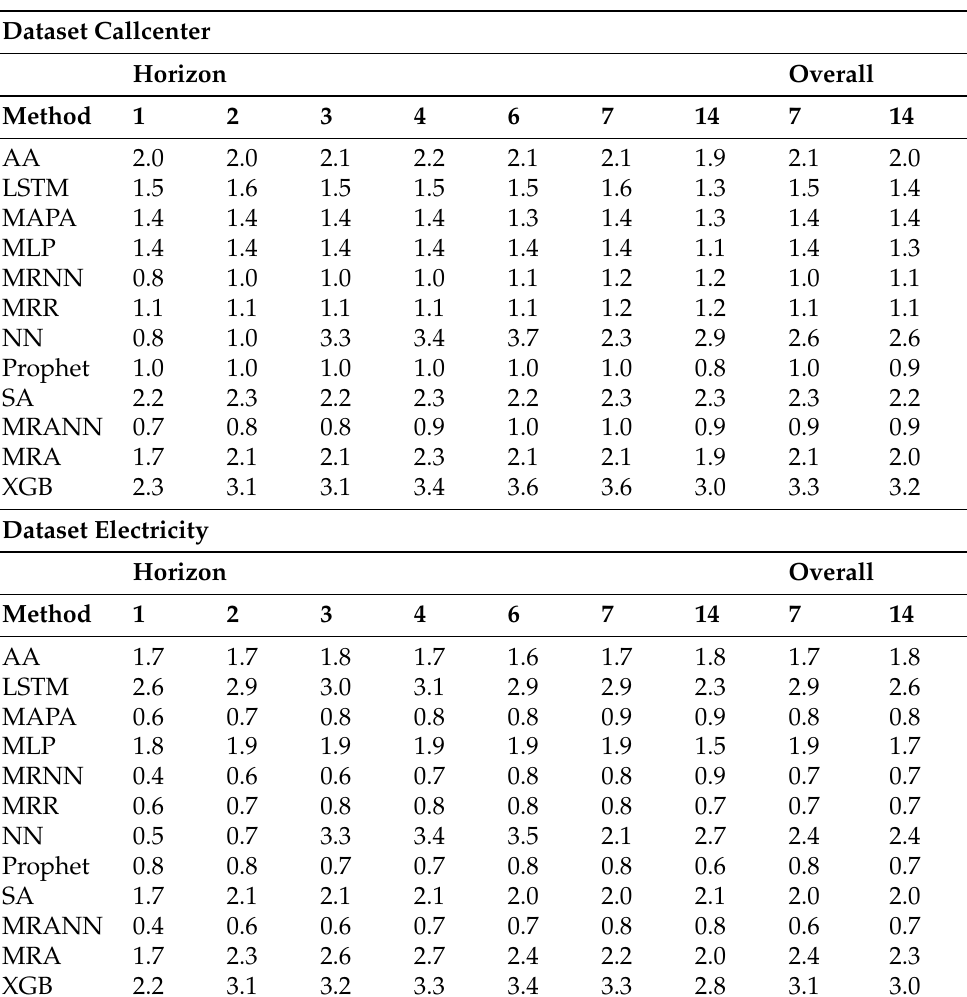
Table 1. Average MASE of multi-step forecasts from Prophet, MAPA, the two multiresolution forecasting methods MRR using regression, and MRNN using a neural network, seasonal adapted ARIMA (SA), automatized ARIMA (AA), multilayer perceptron (MLP), long short-term memory (LSTM) and gradient boosting machine (XGB) for different horizons and for the mean over horizons from 1 to 7 and 1 to 14.